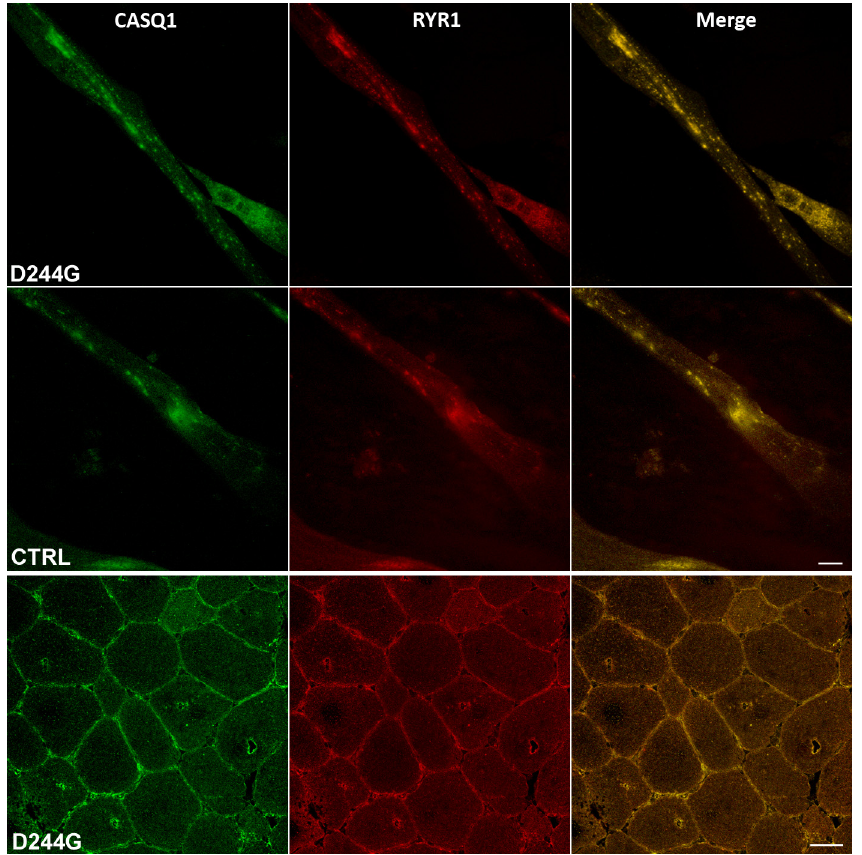
Fig 2. Confocal images of CASQ1 and RYR1 co-localization in both myotube and muscle biopsy. Immunocytochemical staining of RYR1 and CASQ1 in patient ( upper panels ) and control myotubes (intermediate panels; scale bar = 10 μ m). The lower panels show CASQ1 and RYR1 co-staining in vacuoles of fibers derived from a patient muscle biopsy (scale bar = 50 μ